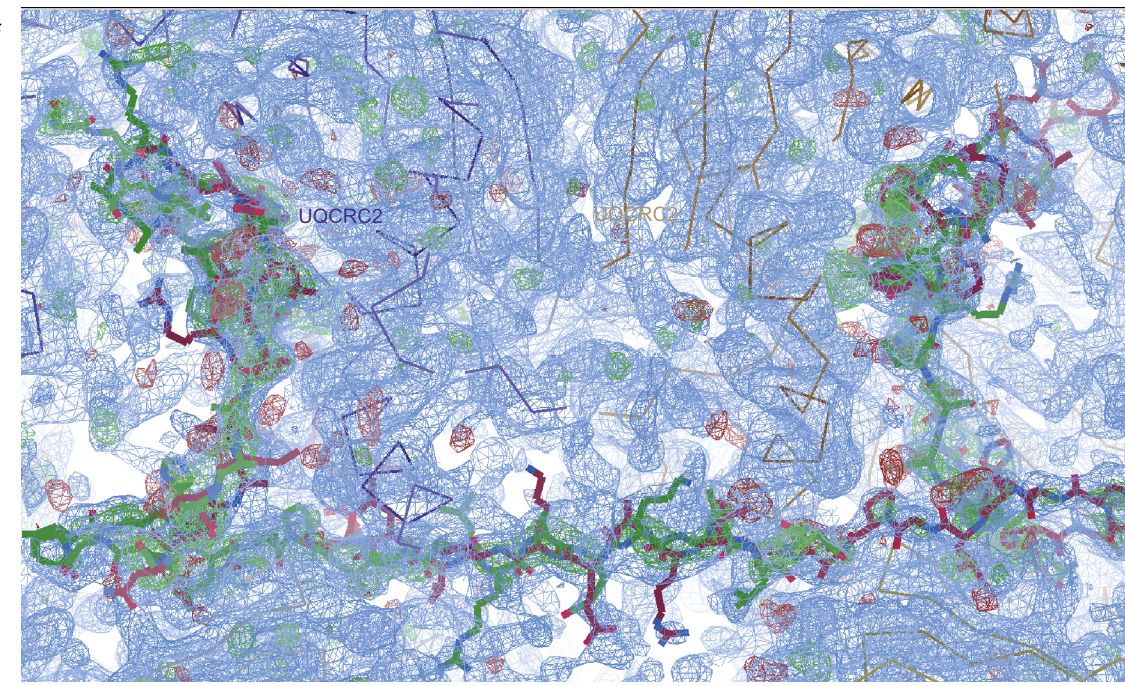
b Figure 1. UQCRFS1N assembles the 21-subunit CIII . (A) The overall re fi ned structure model of the 21-subunit asymmetric bovine CIII (PDB: 2A06). Different subunits of CIII are labelled and shown in different colors. The two possible orientations of UQCRFS1N are shown in red and black, respectively. (B) Structure of the UQCRFS1N subunit in two possible orientations. N and C termini of UQCRFS1N are labelled. This panel is the details of the red dashed frame in (A). (C) The UQCRFS1N structures of bovine CIII (PDB: 2A06). The left panel is viewed along the inner membrane, while the right panel is viewed from the matrix side. UQCRFS1N subunits of two possible orientations are shown in green and purple, respectively. Different subunits of CIII are labeled and shown in different colors. N terminal and C terminal of UQCRFS1N are labeled. The red dashed frames indicate two different binding regions of UQCRFS1N in UQCRC2 and UQCRC1. This fi gure is generated in COOT. (D) The density map of the region indicated by the left red dashed frame in (C). The UQCRFS1N subunits in two switched orientations are shown in sticks and in different colors. l e Green and blue meshes are mFo-DFc and 2mFo-DFc, respectively. C This fi gure is generated by COOT. (E) The density map of the region indicated by the right red dashed frame in (C, bottom panel). Shown & in the same way as (C, bottom panel). (F) The UQCRFS1N maps of n chicken CIII (PDB: 3TGU). Shown in the same way as (C). i e t o r P